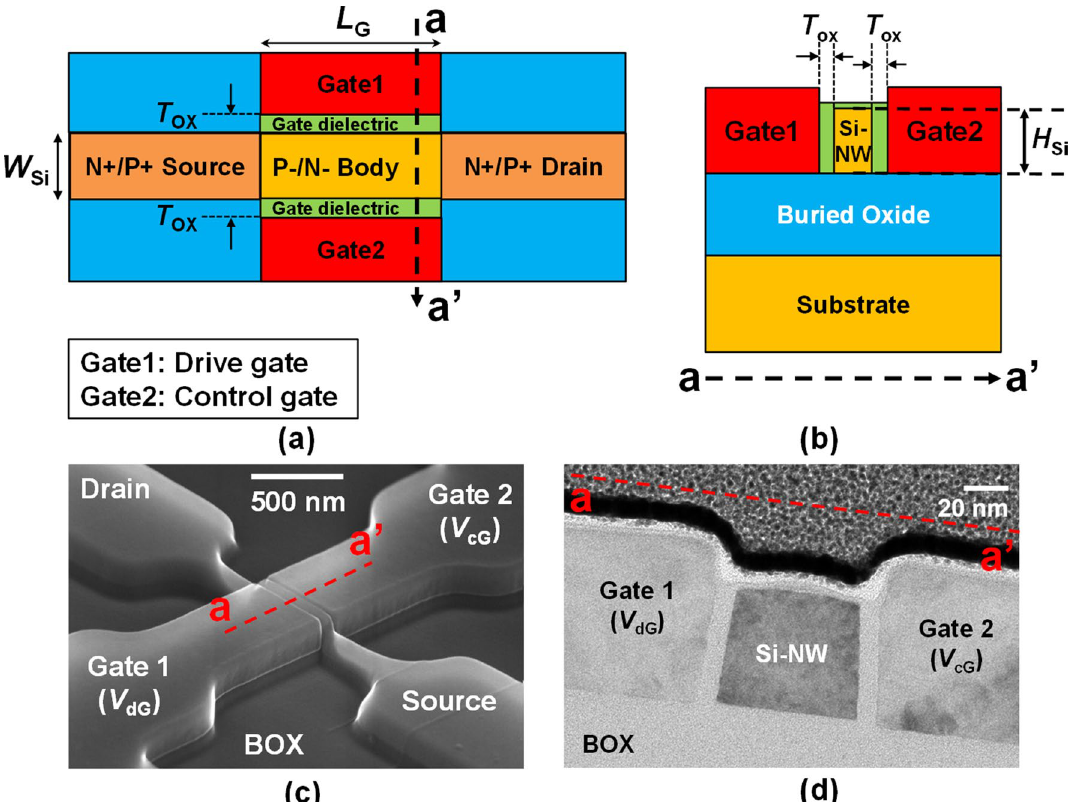
Figure 1. Overall structure of the ICDG Si-NW MOSFET. (a) Cross-sectional schematic of the ICDG Si-NW MOSFET along with the channel direction. (b) Cross-sectional schematic of the ICDG Si-NW MOSFET along with the gate direction. (c) SEM image of the fabricated ICDG Si-NW MOSFET. (d) Cross-sectional TEM image of the fabricated ICDG Si-NW MOSFET along with the gate